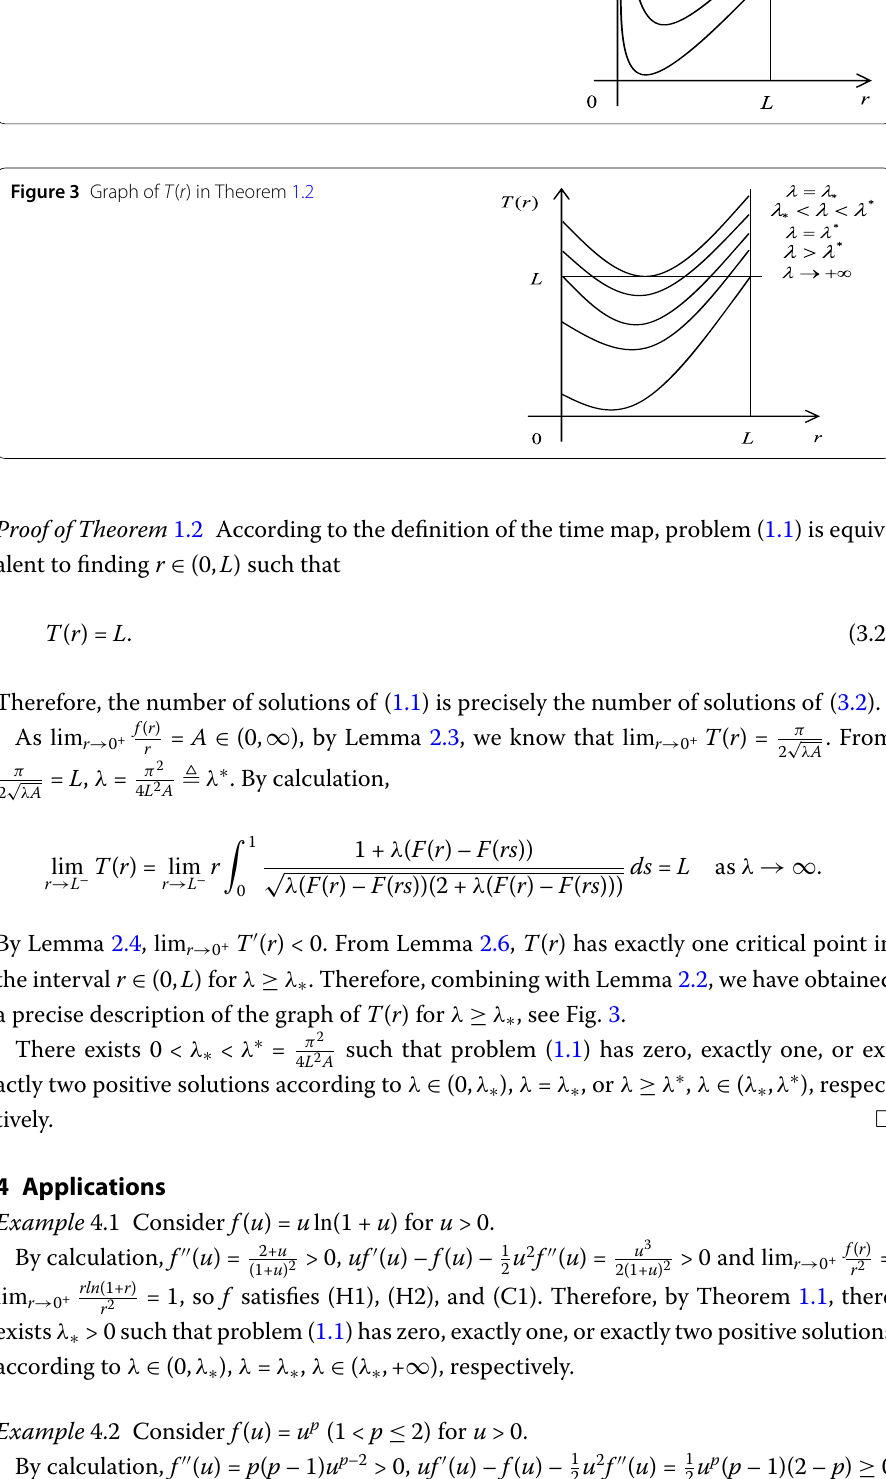
Figure 3 Graph of T ( r ) in Theorem